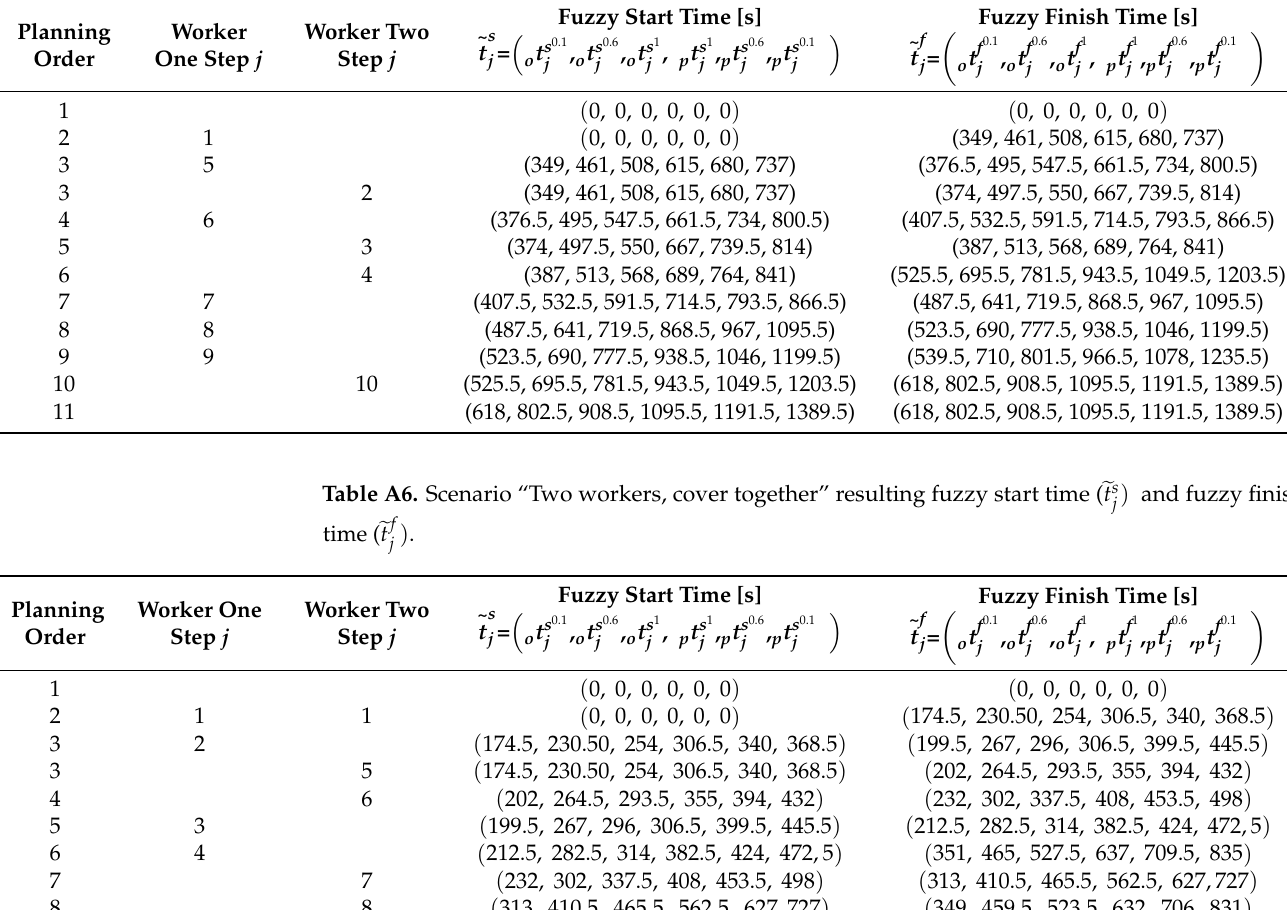
) and fuzzy finish time ( (cid:101) t f j